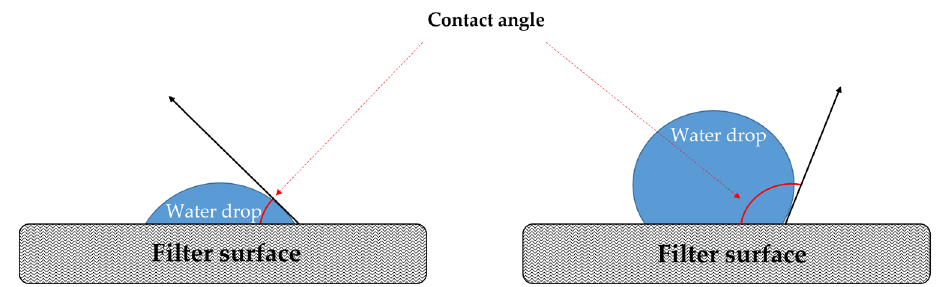
Figure 4. Schematic representation of a water drop on a filter surface .